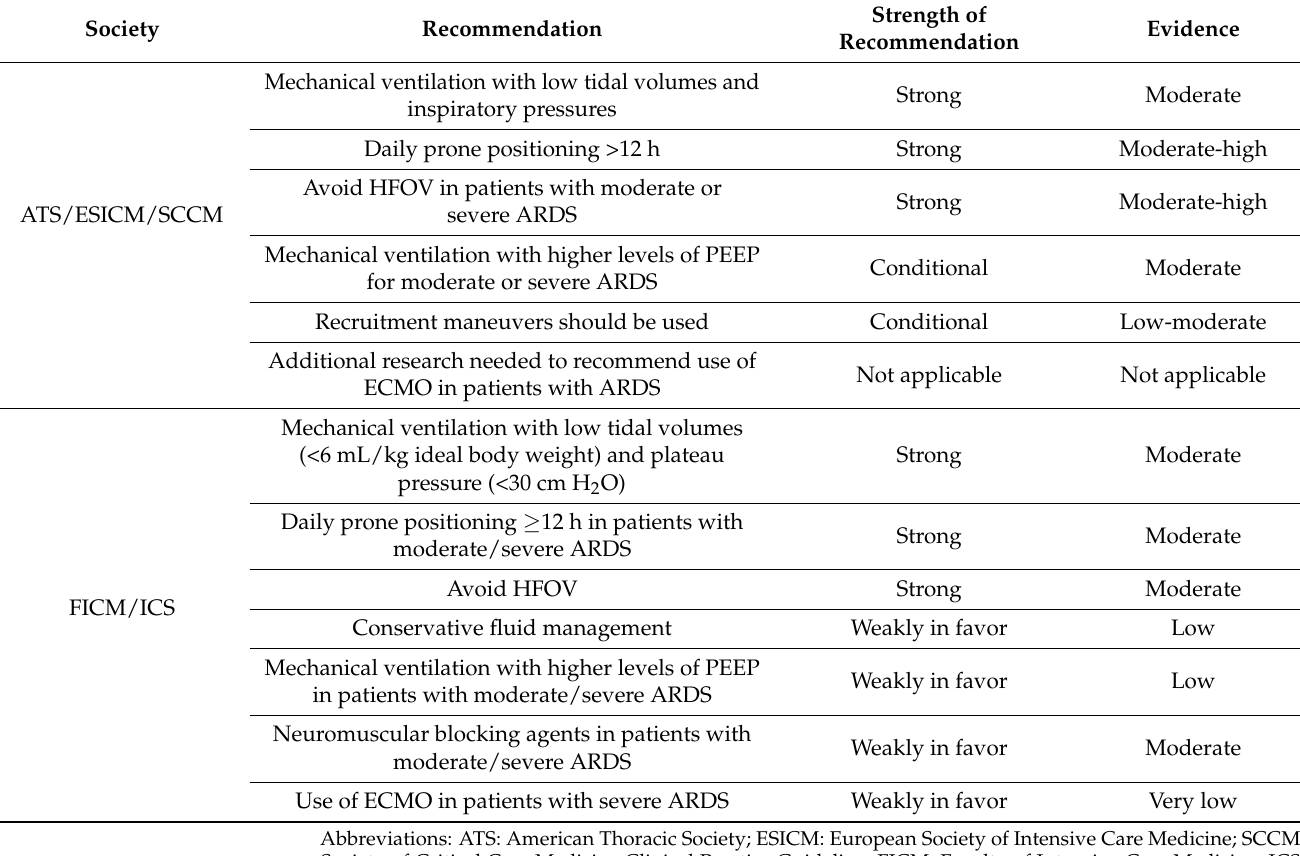
Table 1. Summary of current guidelines for mechanical ventilation in adult patients with ARDS